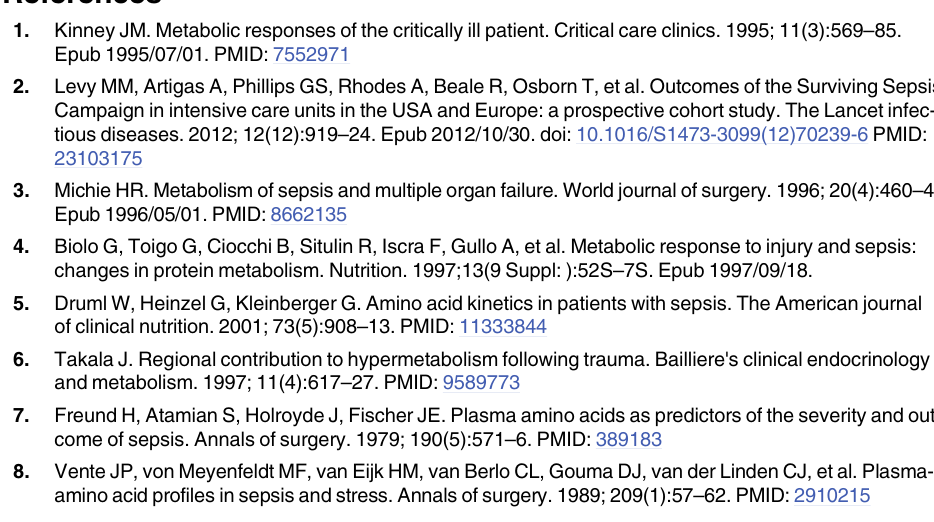
S1 Table. LC gradient for the assay. S2 Table. Mass transitions for amino acids and their corresponding internal standards. S3 Table. Comparison of amino acid serum concentrations between sepsis (12 cases) and severe sepsis (23 cases) groups. S4 Table. Comparison of amino acid serum concentrations between survivor (20 cases) and non-survivor (15 cases)